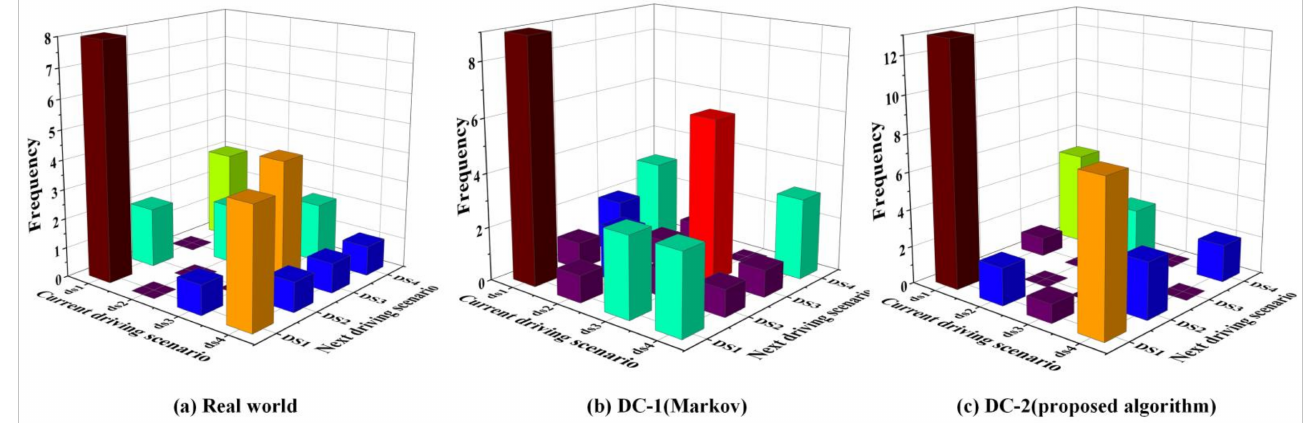
Figure 20. Driving scenario transition probability (real DC, DC-1, and